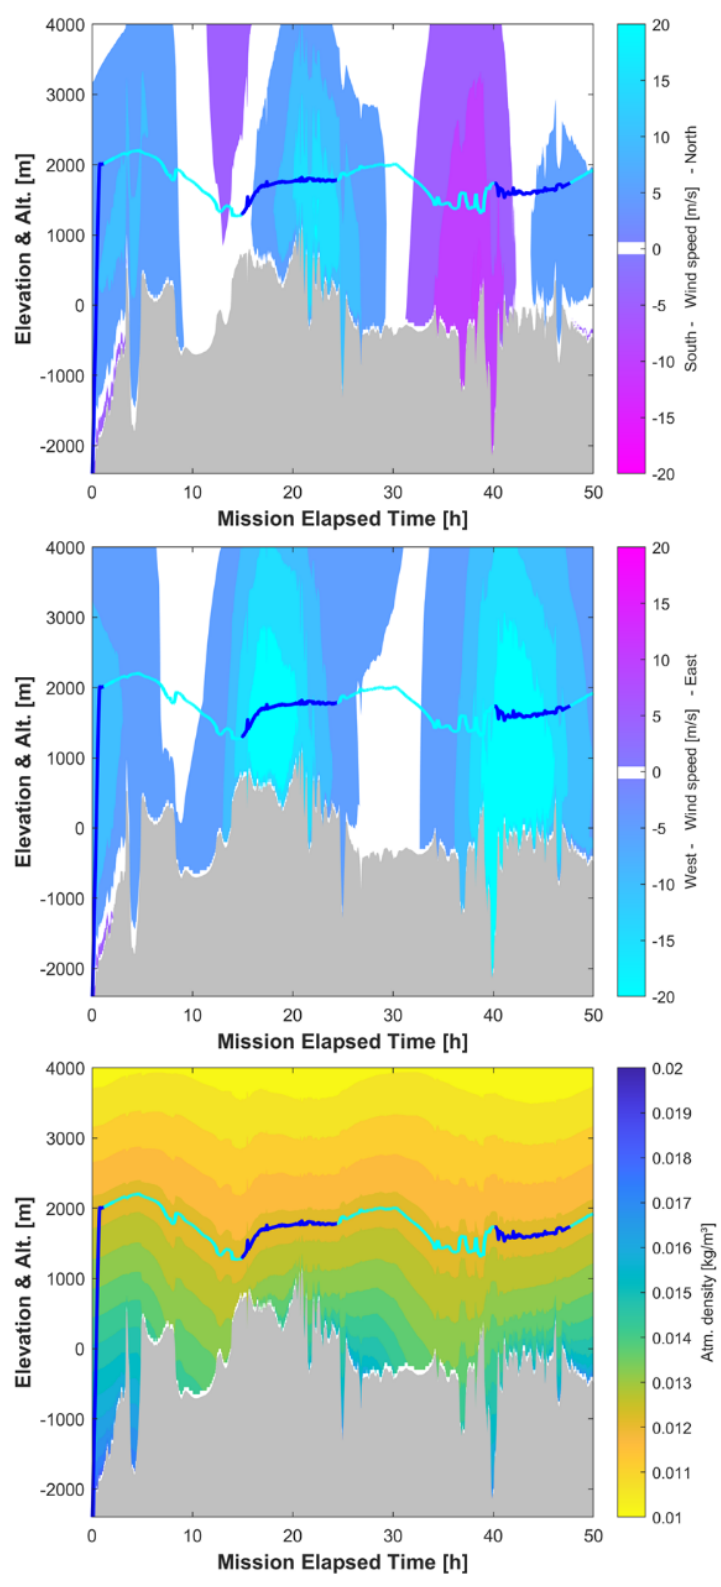
Figure 4. Altitude/elevation charts for the Ls = 60° scenario showing the color-shaded variations over altitude and along time of meridional ( top ) and zonal ( middle ) winds and atmospheric density ( bottom ). The gray shaded area represents the terrain elevation at the momentary balloon position. A similar figure for the Ls = 240° scenario is shown in Appendix A.